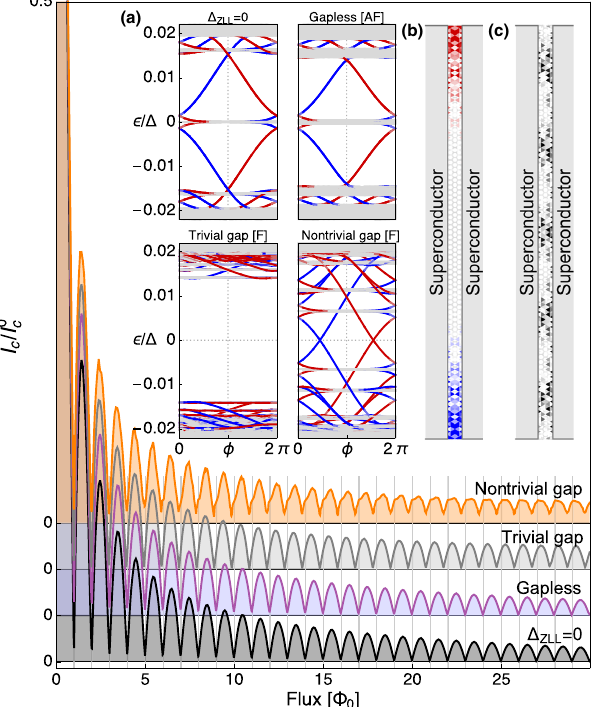
=I 0 FIG. 2. Normalized critical current I as a function of c c magnetic flux through a Josephson junction. Curves from bottom to top (shifted for better visibility) correspond to the noninter- acting case (black), the gapless AF phase (purple), a trivially gapped AF phase (light gray), and a ferromagnetic phase with a topologically nontrivial gap (orange). Only the latter shows nondecaying nonzero minima in I , a consequence of an Andreev c spectrum [inset (a)] with an odd number (one) of edge-resolved zero-energy crossings (bottom-right panel). States colored in red and blue are located at the top and bottom edges, respectively [inset (b)], while states in gray are spread across the width of the junction [inset